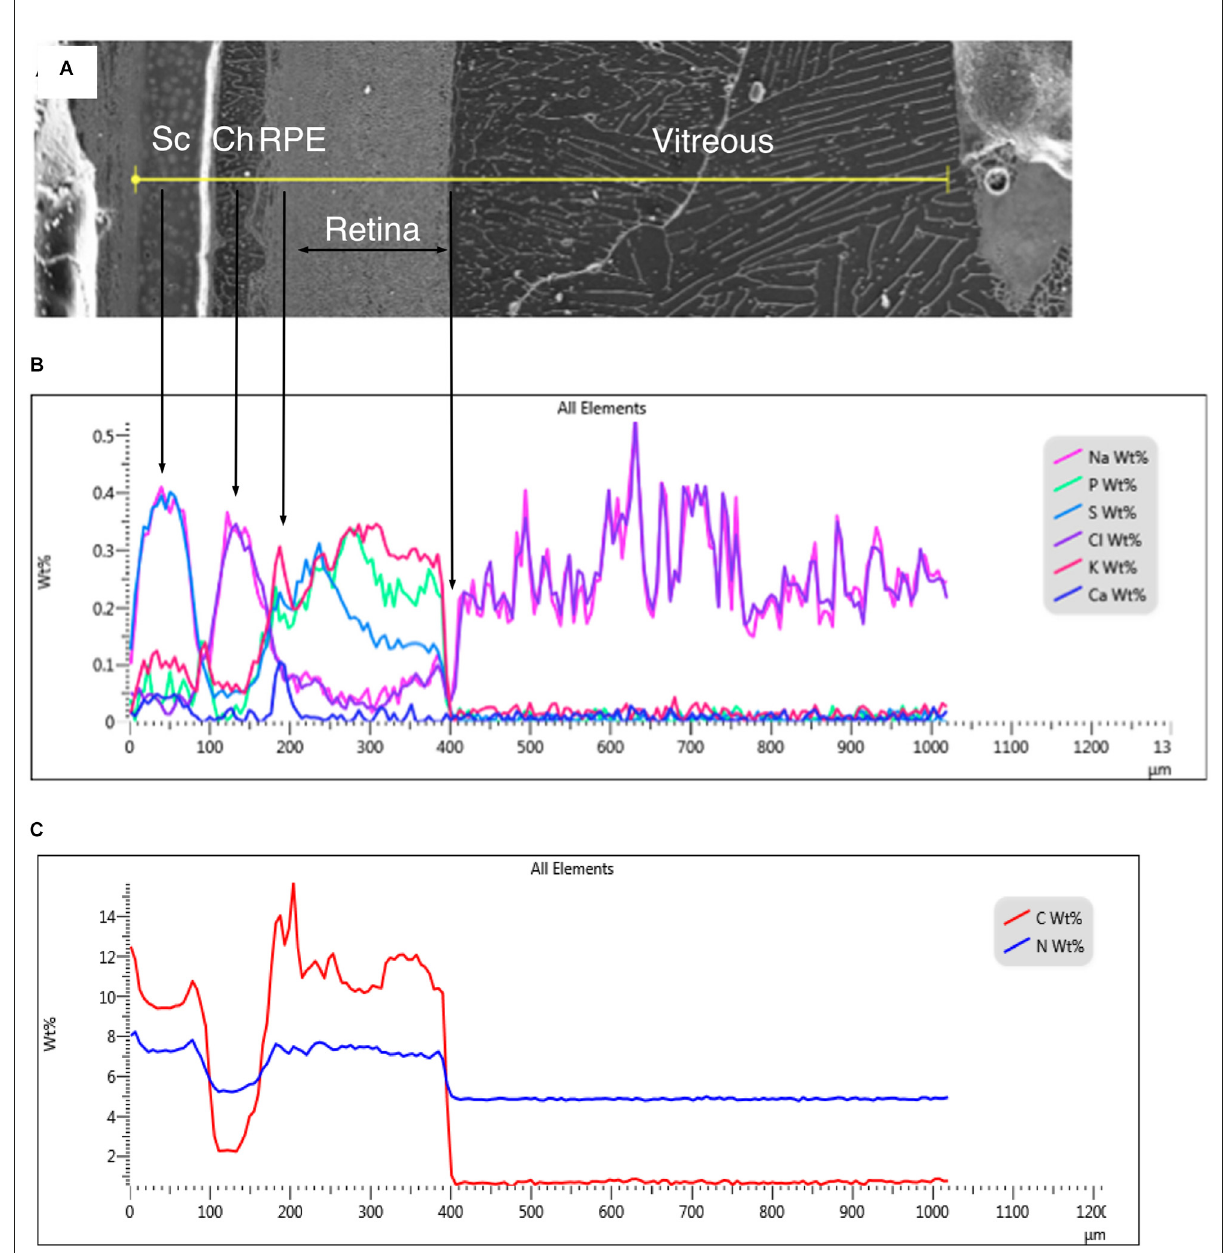
FIGURE1 (A) Secondary electron image of a region of frozen-hydrated chick eye. Sc, sclera; Ch, choroid; RPE, retinal pigment epithelium. The yellow line indicates the position of the line-scan in (B) . (B) Quantitative line-scan of various elements in weight percent. (C) Quantitative line-scans of N and C in weight